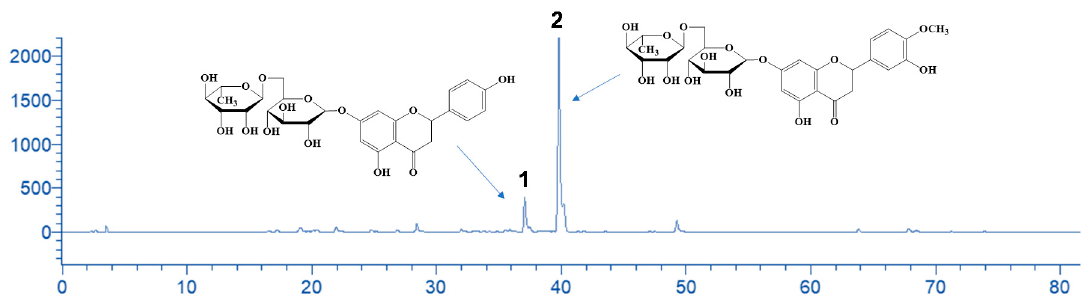
Figure 4. HPLC trace of a waste orange peels (WOP) extract, produced with hydroxypropyl β - cyclodextrin (HP- β -CD), at pH 4 and 40 °C. The trace was recorded at 280 nm. Peak assignment: 1, β -cyclodextrin (HP- β -CD), at pH 4 and 40 ◦ C. The trace was recorded at 280 nm. Peak assignment: narirutin; 2, hesperetin. 1, narirutin; 2, hesperetin.